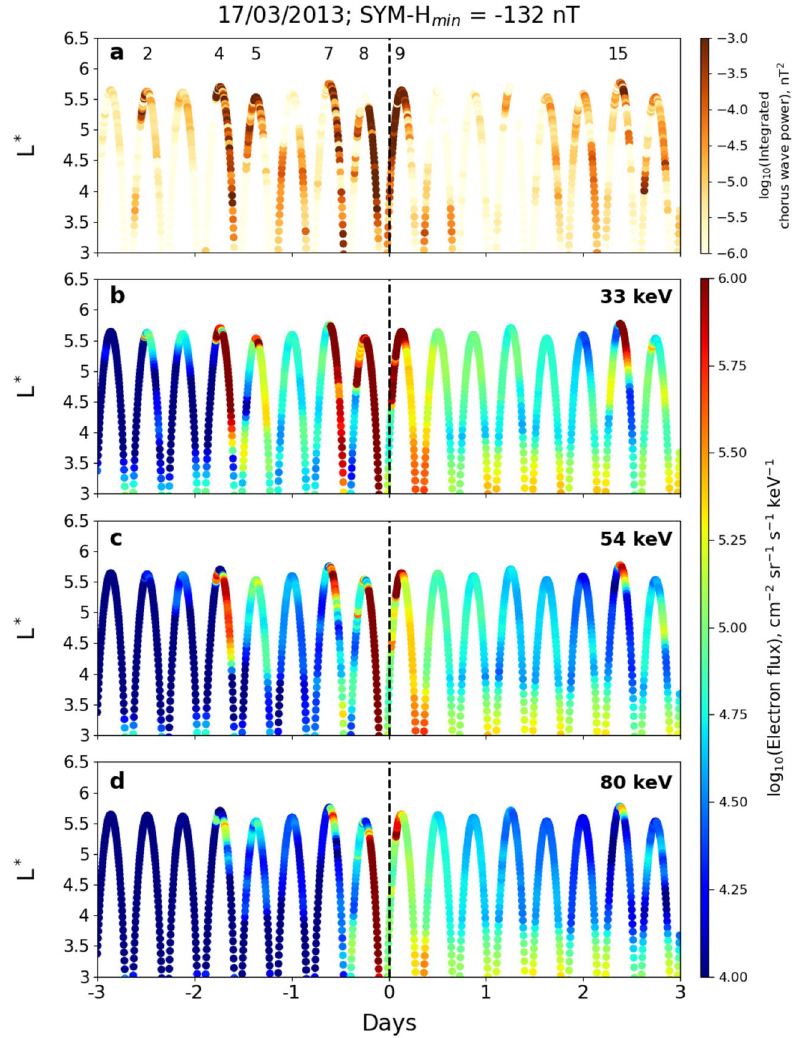
Figure 1. ( a ) Integrated chorus wave power, P ch , and electron fluxes in three energy channels: ( b ) 33 keV, ( c ) 54 keV, and ( d ) 80 keV in logarithmic scale as a function of L ∗ and time as observed by Van Allen Probe-A during the geomagnetic storm on March 17, 2013. The observations are made over a period of 6 days starting from 3 days before minimum SYM-H (day 0, marked by vertical dotted line in each panel) to 3 days after minimum SYM-H. The colorbars at the right denote the corresponding integrated chorus wave power (panel a ) and electron fluxes in logarithmic scale (panels b – d ). In panel ( a ), the orbit numbers in which intense chorus waves 4 (wave power typically > 10 − nT 2 ) are observed are also